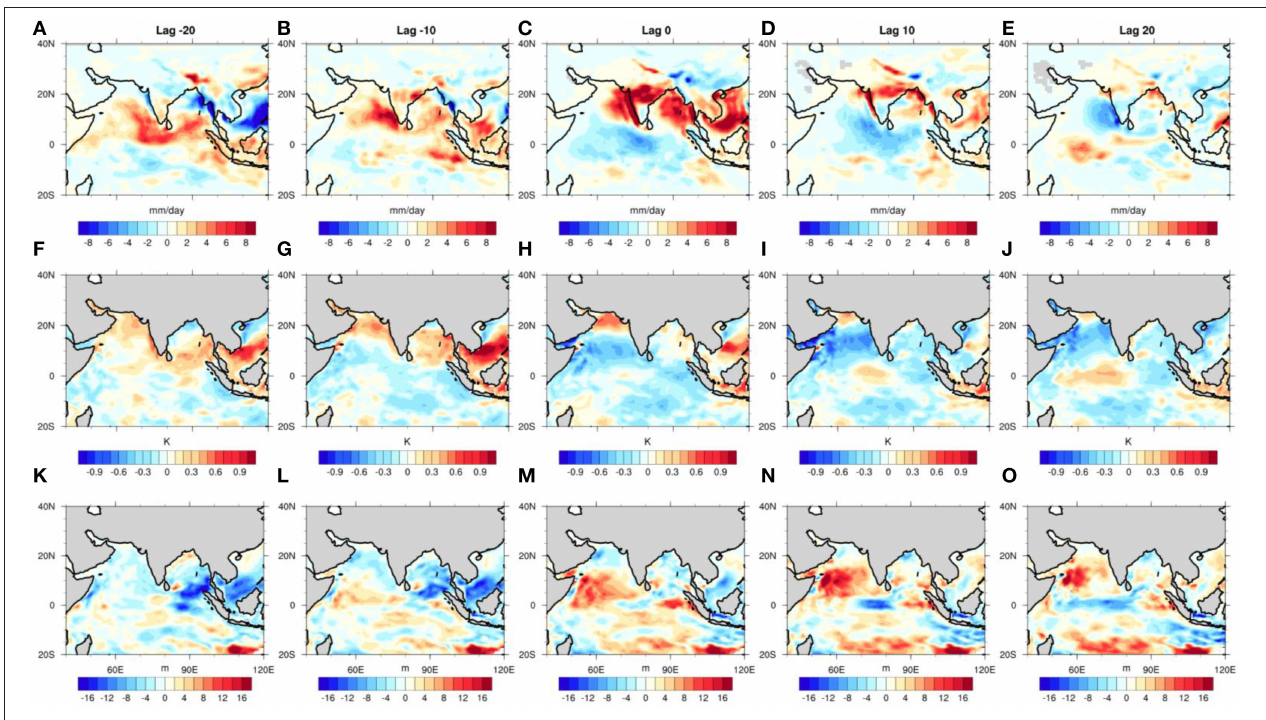
FIGURE 6 | Same as Figure 5 , but for extended active